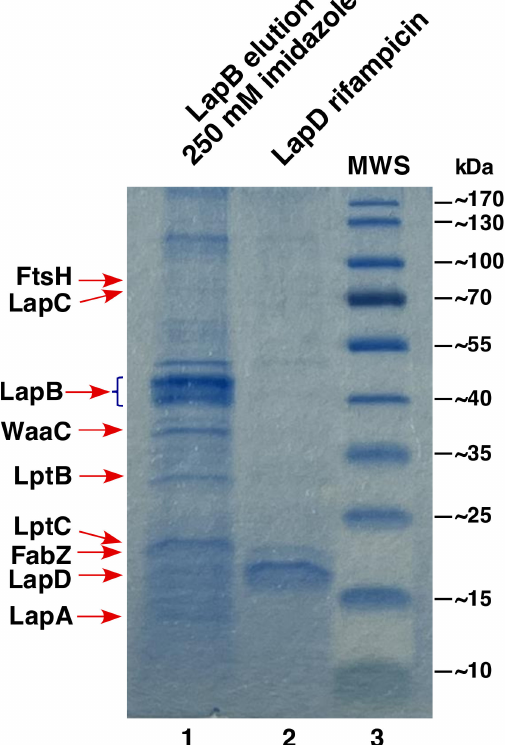
Figure 3. LapD as a new interacting partner of LapB. Purification profile of His 6 -tagged LapB protein from the IM fraction after elution with 250 mM imidazole. Lane 1 shows co-purifying proteins with LapB that include LapD. All major co-purifying proteins are indicated by arrows. In lane 2, purified LapD protein was applied. Proteins were resolved on a 12% SDS-PAGE, stained by Coomassie Brilliant Blue. Lane 3 shows pre-stained molecular weight